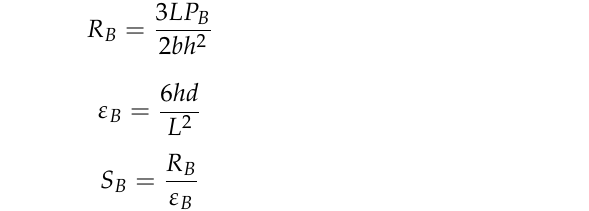
Figure 14. Elastic modulus.